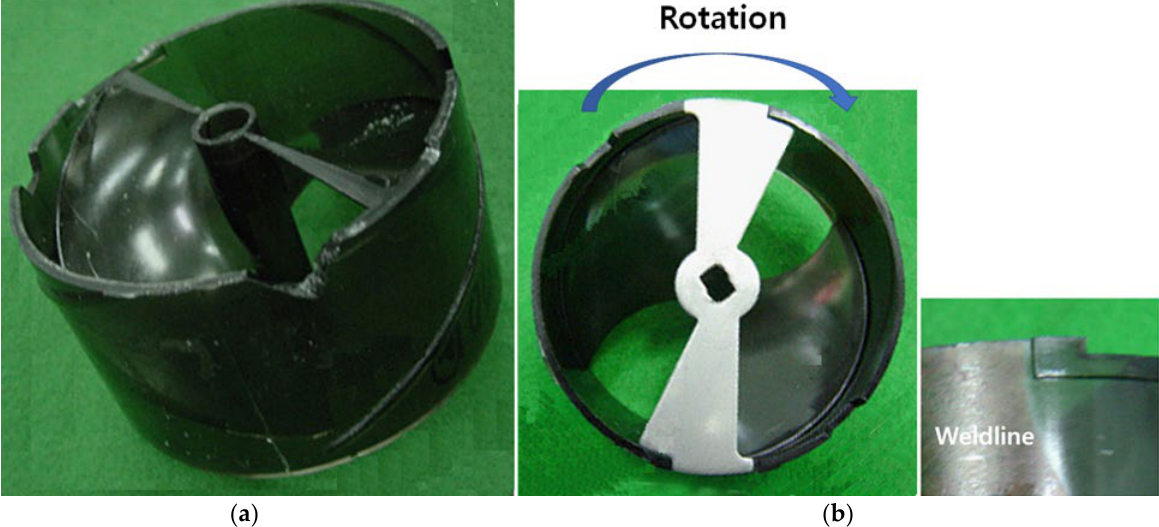
Figure 13. Unsuccessful products on the Weibull plot: ( a ) failed products at the market and ( b ) failed products after first ALT.